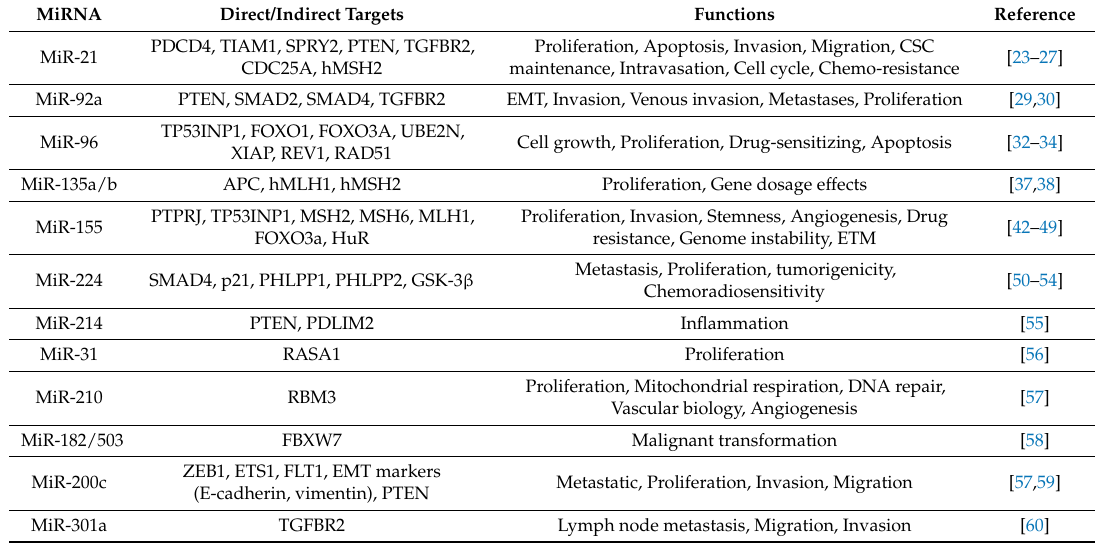
Table 1. The up-regulated oncomiRs in